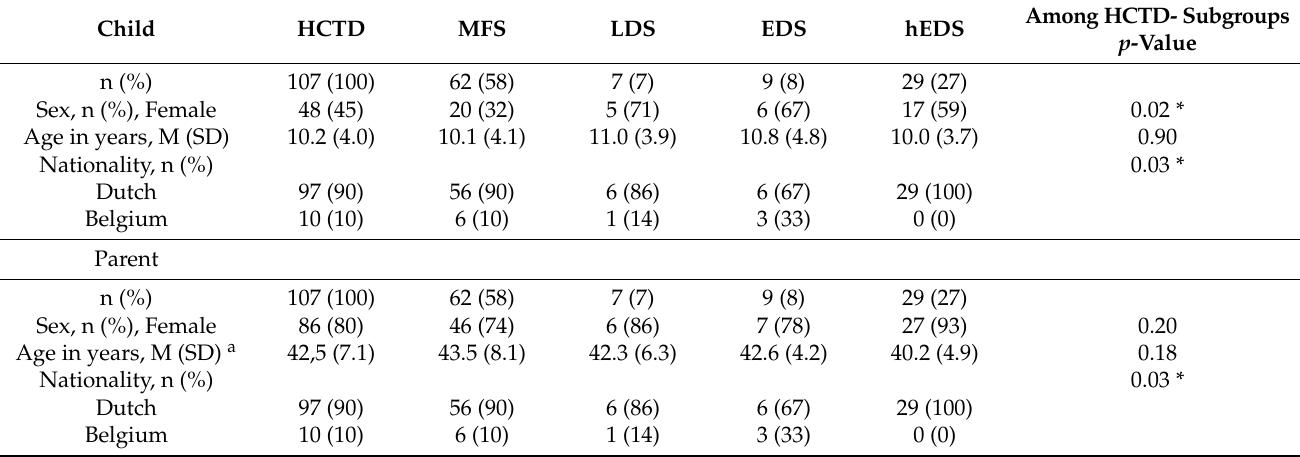
Figure 1. Legend: This figure shows the mean 95% confidence interval (CI) of the Childhood Health Assessment Ques- tionnaire disability index (CHAQ-DI) score (range 0–3), PROMIS Fatigue Parent Proxy T-score (range 0–100), pain Visual Analogue Scale (VAS) score (range 0–10) and general health VAS score (range 0–10) of the normative data, the Heritable Connective Tissue Disorders (HCTD) group, and the following HCTD-subgroups: Marfan syndrome (MFS), Loeys-Dietz syndrome (LDS), Ehlers-Danlos Syndromes (EDS) and hypermobile Ehlers-Danlos syndrome (hEDS). * Compared to the normative data, this HCTD (sub)-group shows a significant difference. Table 1. Participants: sex, age and nationality of children of the HCTD-group, the HCTD-subgroups: MFS, LDS, EDS, hEDS; and of the parents who completed the